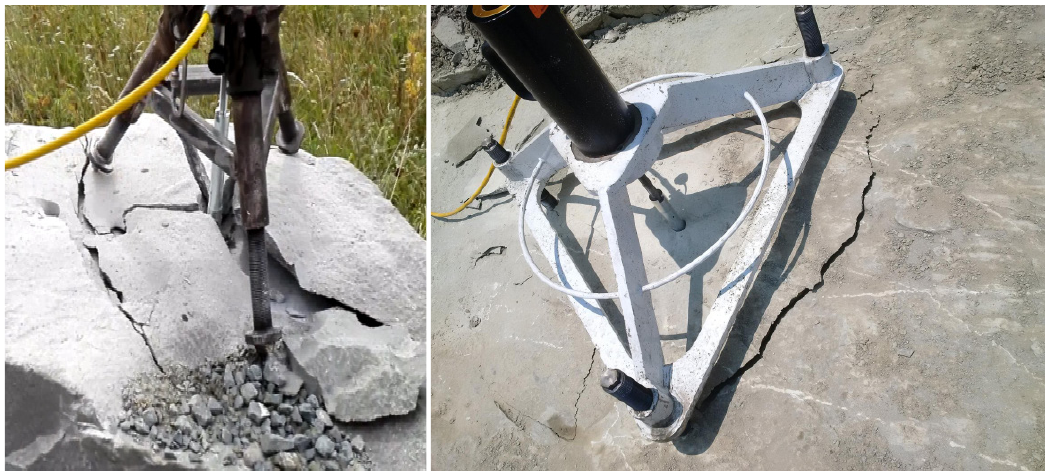
Figure 13: Pull-out test performed on actual rock (Jonak et al.,